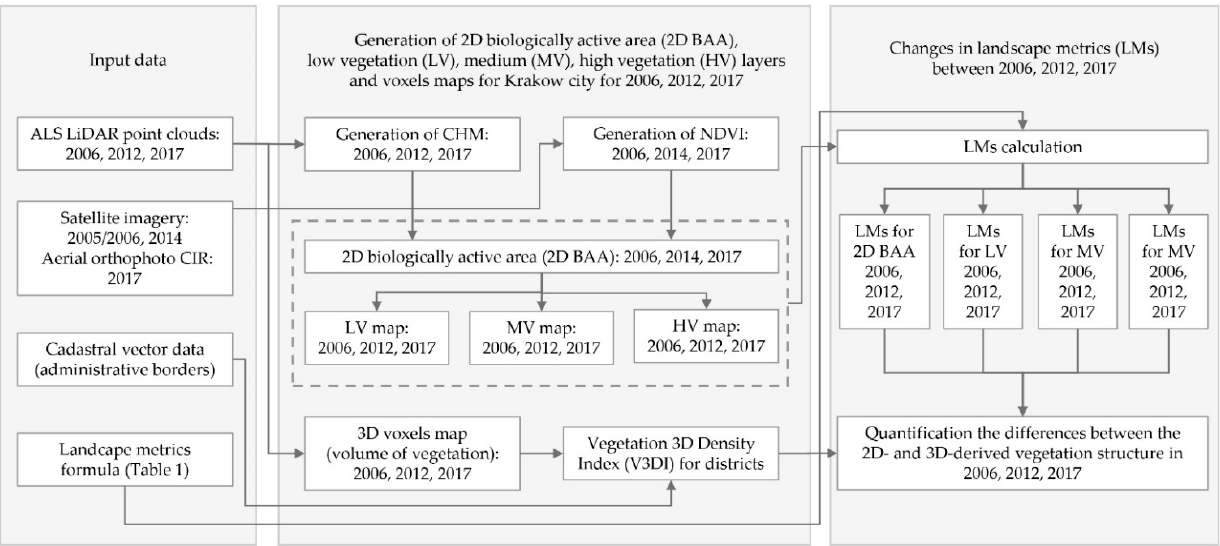
Figure 3. Flowchart of analyses (ALS—Airborne Laser Scanning; CHM—Canopy Height Model; CIR—Color-InfraRed; NDVI—Normalized Difference Vegetation Index; 2D BAA—2D biologically active area; LV—low vegetation; MV—medium vegetation; HV—high vegetation; LMs—landscape metrics).